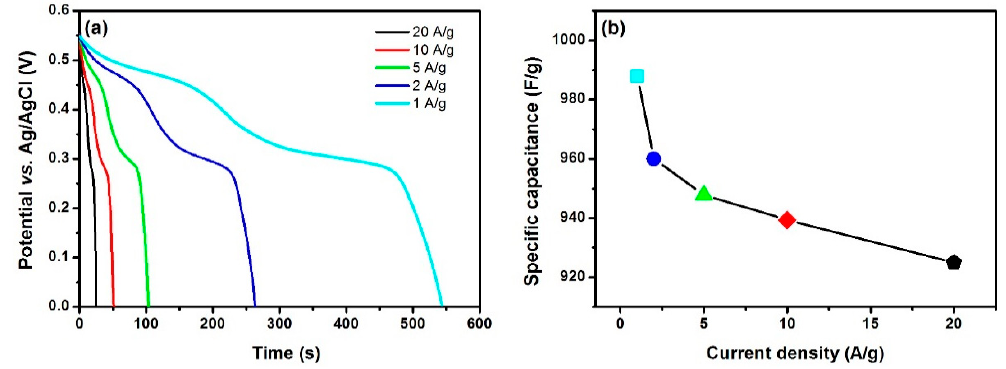
Figure 5. ( a ) Discharge curves and ( b ) specific capacitances of the Co 3 O 4 electrode at different current densities.